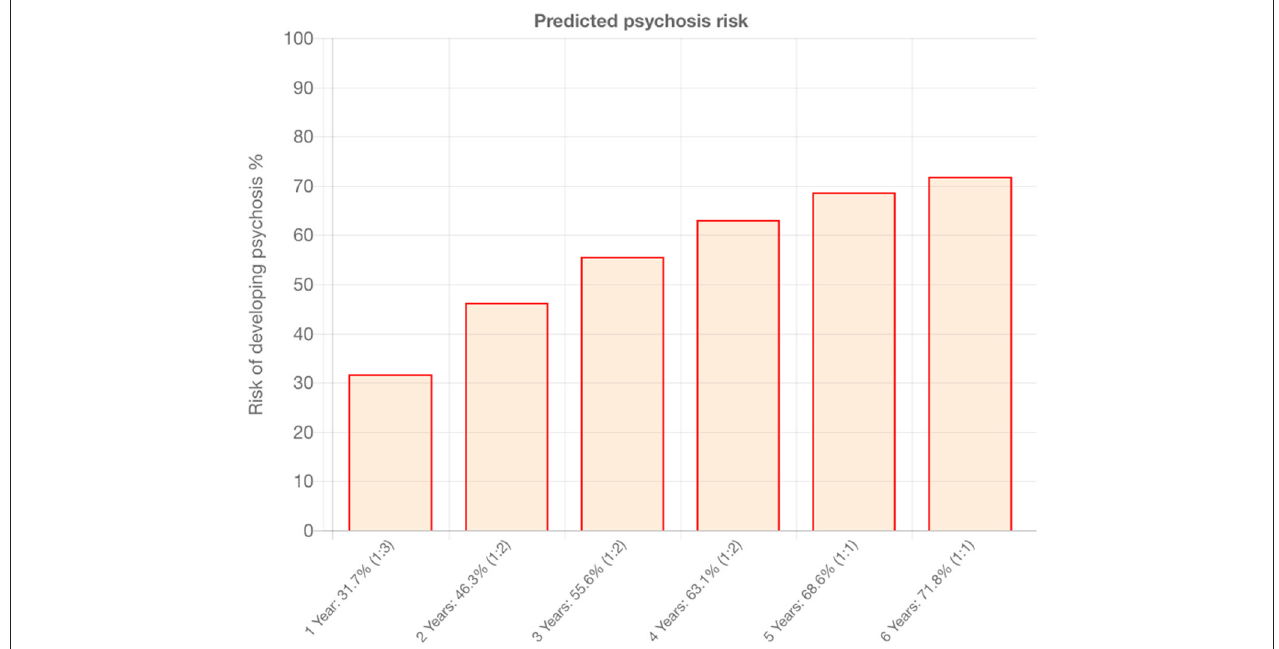
FIGURE 2 | Example of outcomes produced by the transdiagnostic risk calculator that is under implementation in the current study.